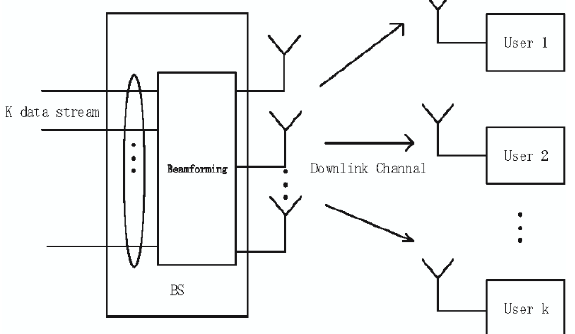
Fig. 3. The basic model of massive MIMO.